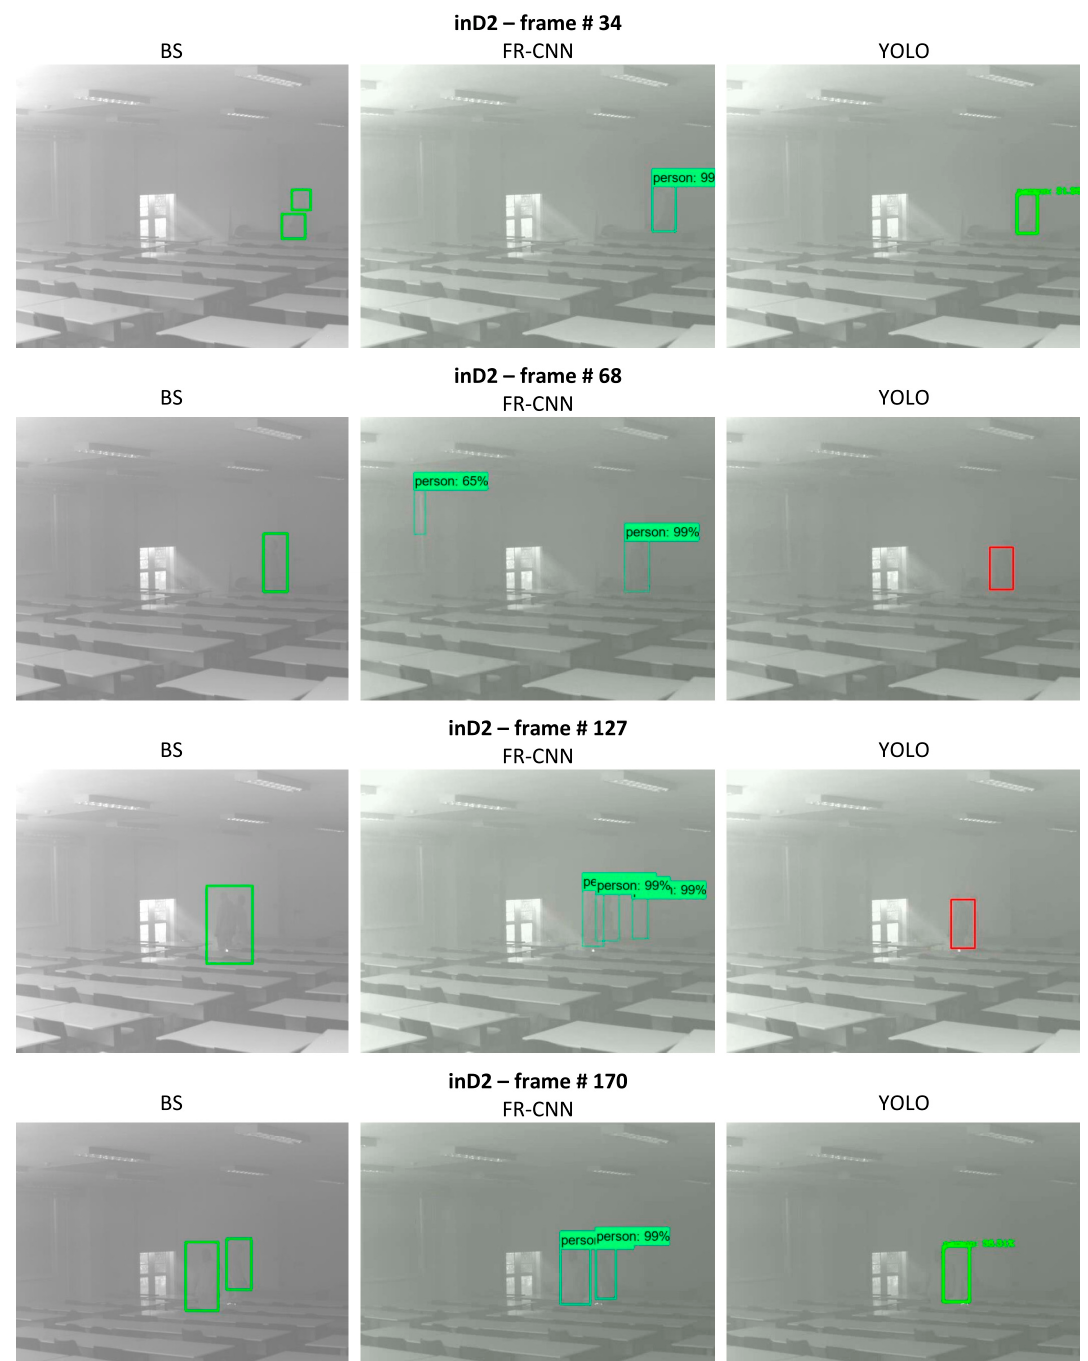
Figure 12. Indicative detection examples overlaid onto the SWIR data for the second indoor dataset (inD2) with the presence of significant smoke based on the integrated BS, FR-CNN, and YOLO